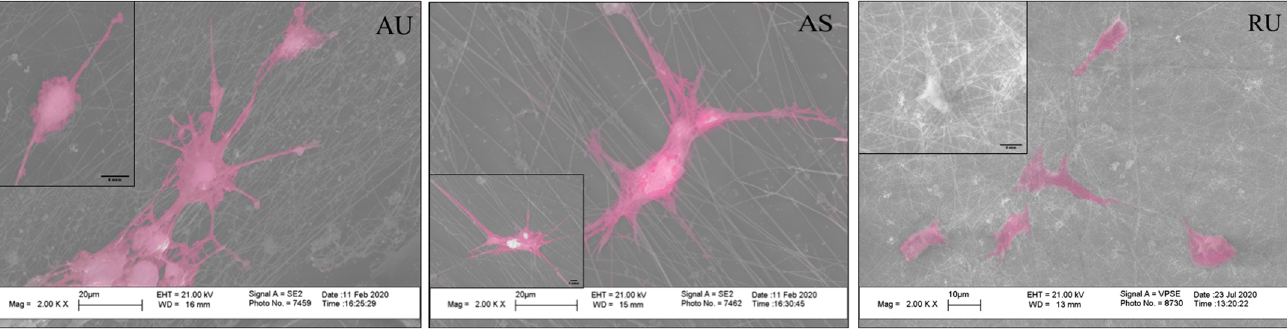
Figure 4. SEM images with color enhancement of rat hippocampal neurons cultured on nanostructured nylon scaffolds for 7 days. Insert—10 μ m. The cells are pseudo-colored pink for contrast.